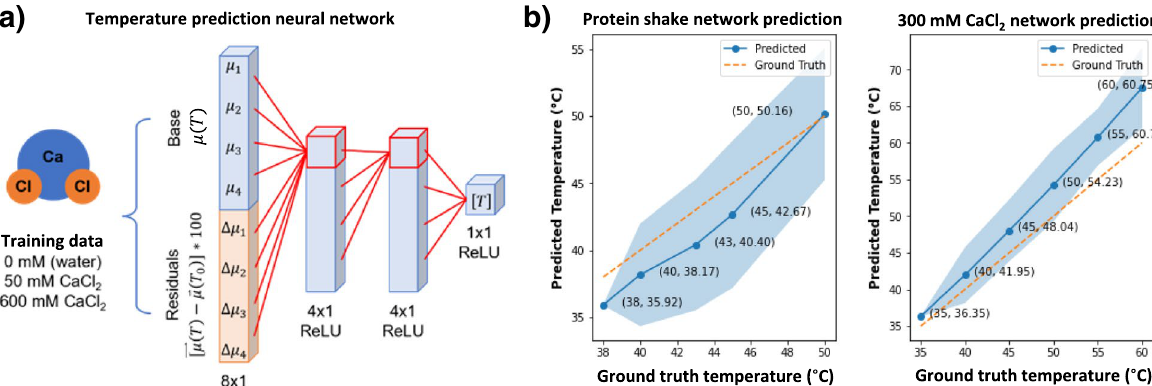
Fig. 3 Summary of experiment results. a The fully connected neural network architecture used to non-linearly model the relationship between attenuation and temperature. The input to the network are the spectral attenuations of a material at a baseline temperature concatenated with the attenuation residuals due to heating; b Visualization for network performance for predicting temperature on 300 mmol/L CaCl 2 and a milk-based protein shake. The data points are labeled in the (xx, yy) format where xx is the predicted temperature and yy is the ground truth temperature synchronously measured with a digital thermometer. The 95%CI of temperature prediction is shaded. Data from the testing samples were not included in the training